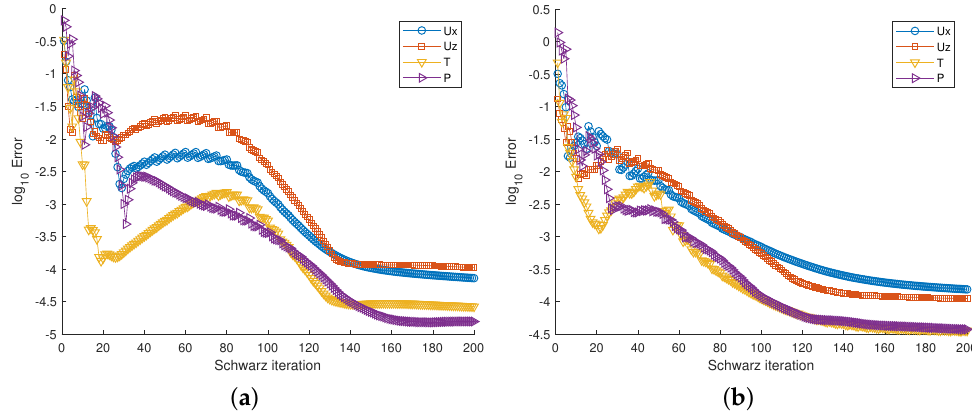
Figure 15. Graph of the log 10 of the errors in the velocity, temperature, and pressure fields for the Schwarz iterations: ( a ) R = 1300, Γ = 27.96, np = 14, mp = 2, N × M = 16 × 10; ( b ) R = 5000, Γ = 27.96, np = 13, mp = 3, N × M = 18 ×